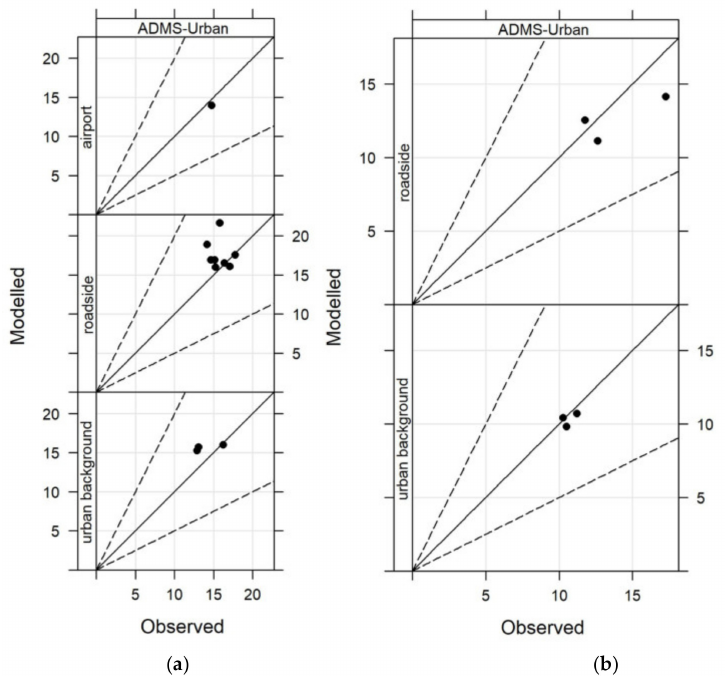
Figure 5. Comparison of annual averages between model output and measurement: ( a ) for PM 10 (in µ g m − 3 ); ( b ) for PM 2.5 (in µ g m − 3